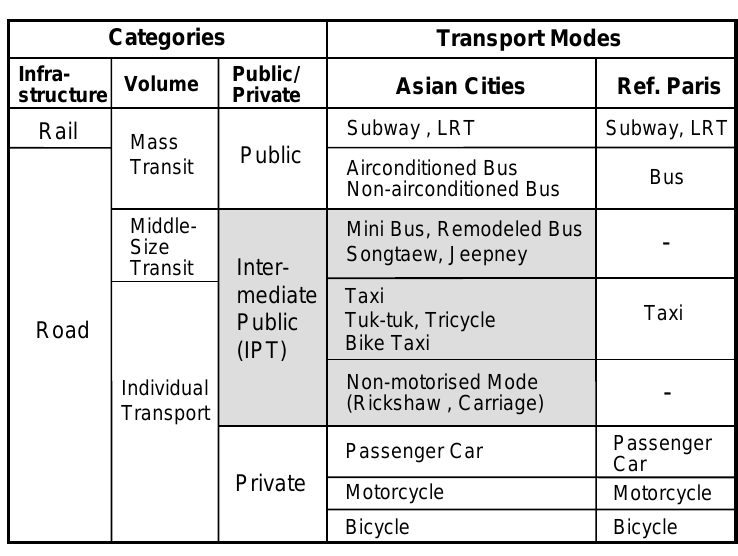
Table 1. A variety of transport modes in Asia